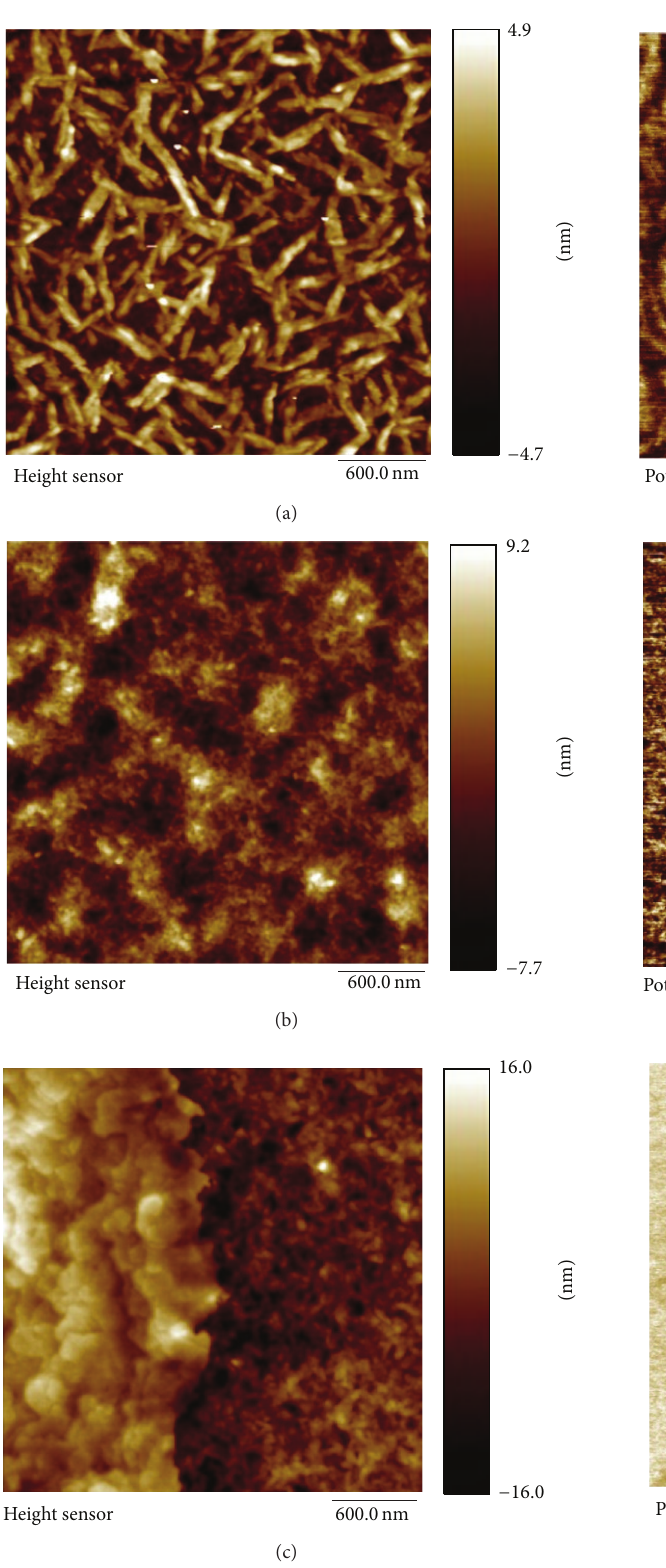
Figure 5: AFM images of the as-cast (a), best performing-SVT with THF for 4s (b), and degraded-SVT with THF for 80 s (c).